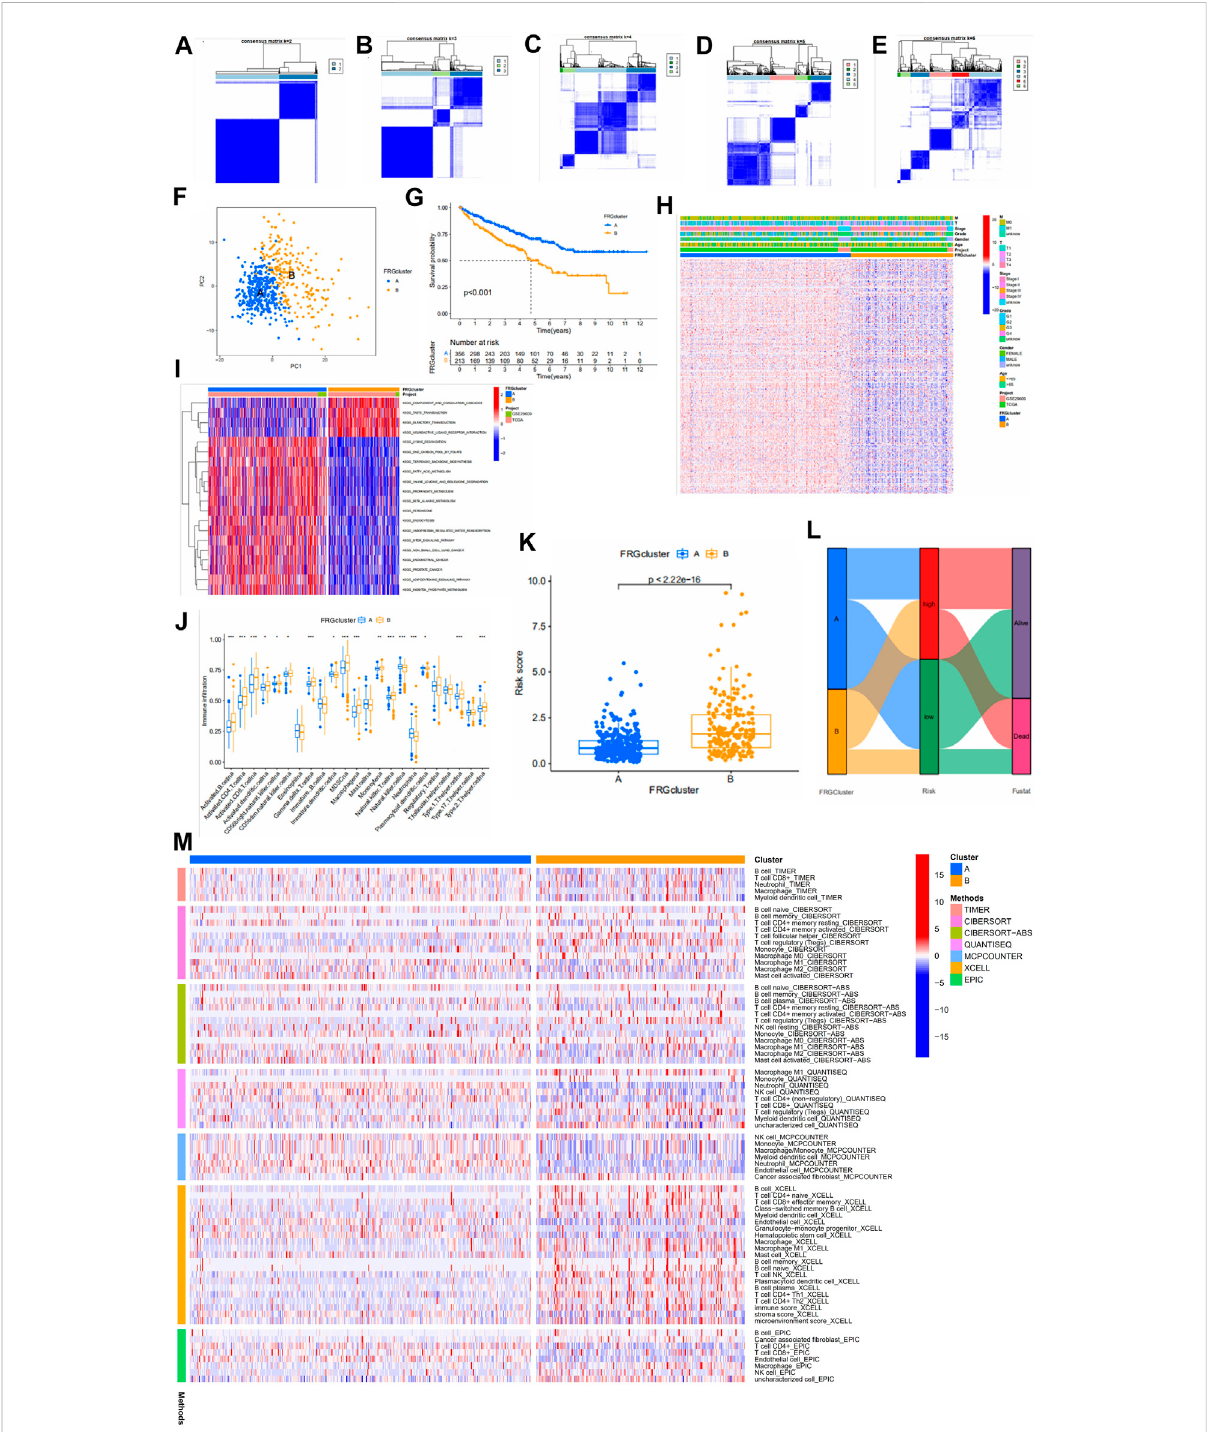
FIGURE 5 (A – E) Results of unsupervised consensus clustering analysis. De fi ned as two, three, four, fi ve, and six subtypes and their areas. (F) The results of PCA analysis between the two subtypes. The fi gure shows signi fi cant differences in fatty acid metabolism-related genes between the two subtypes. (G) Survival curves between the two subtypes. (H) Comparison between clinical indicators and the two subtypes. (I) Differences in biological pathways analyzed by GSVA (gene set variation analysis) in two subtypes. Red for pathways of activation and blue for pathways of inhibition. (J) Differences in the level of immune cell in fi ltration in the two subtypes. (K) Association of different subtypes with risk scores. Each point represents a patient. (L) Sankey diagram showing the distribution of patients. (M) Multiple methods to calculate the immune cell content of two fatty acid metabolic